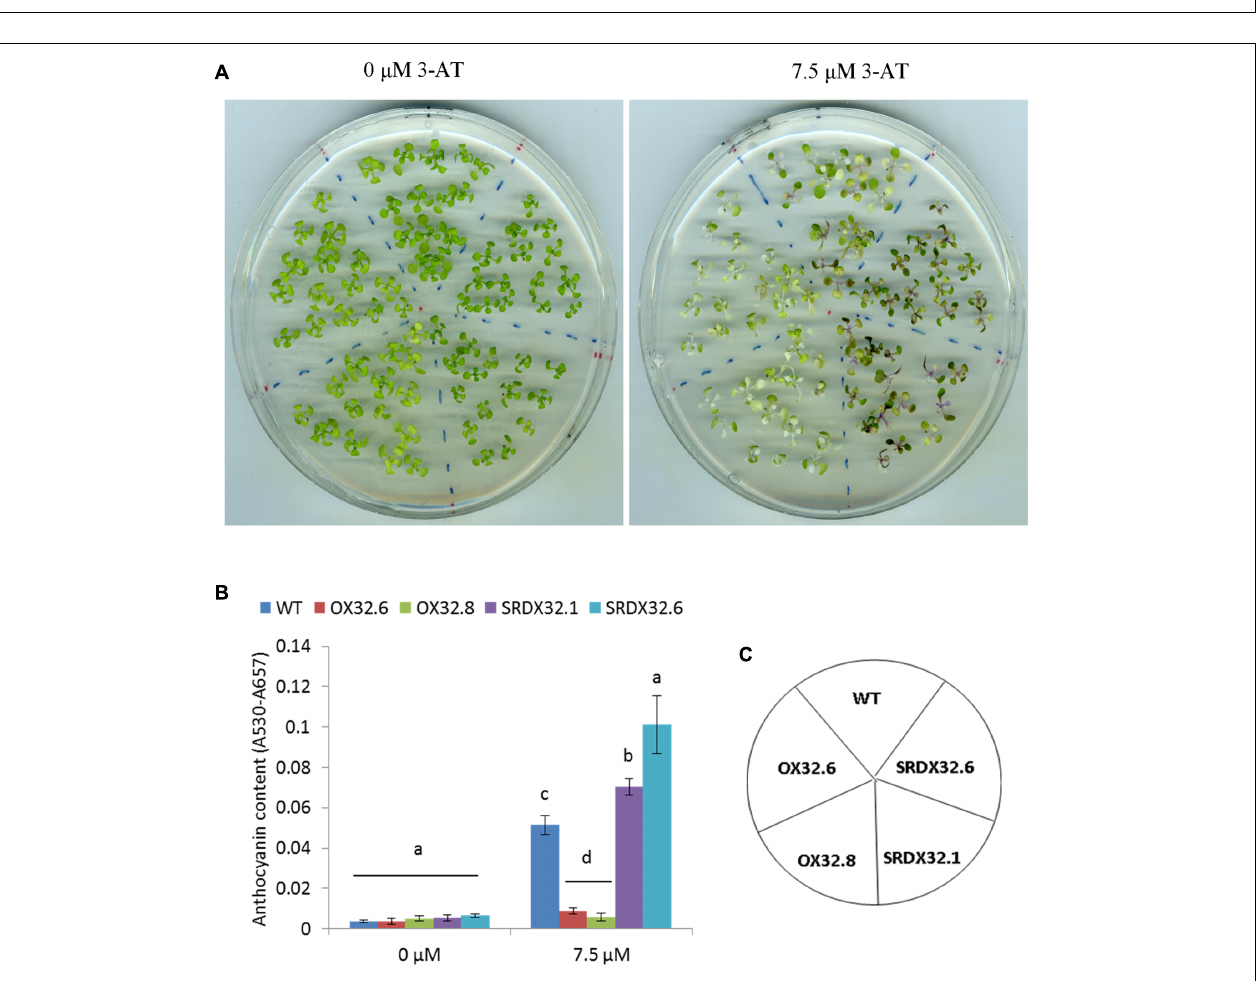
FIGURE 2 | Regulation of high light-induced anthocyanin biosynthesis. (A) Expression analysis of ANAC032 in response to high light stress using qRT-PCR assay. Data represent mean values ( ± SD). ACT7 was used as internal control. Data were analyzed statistically using Student’s t -test ( ∗∗∗ P < 0.01). (B) β -glucuro- nidase activity of P ANAC032 : GUS line in response to high light treatment. Twenty-day-old plants of P ANAC032 : GUS line were transferred to control/optimal (150 µ mol m − 2 s − 1 ) and high light ( ∼ 1000 µ mol m − 2 s − 1 ) for 24 h and then incubated in GUS-staining solution overnight (scale bar = 1 cm). (C) Phenotype of WT and ANAC032 transgenic lines grown under optimal (control) and high light. (D) Biochemical analysis of anthocyanin content in WT and ANAC032 transgenic lines in response to high light stress. (E) Analysis of total soluble sugars in response to HL stress. 17-day-old plants of WT and ANAC032 overexpression and SRDX lines